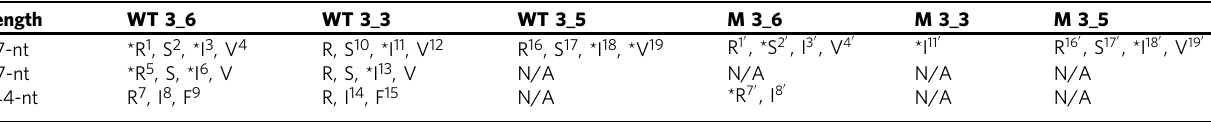
Table 1 FSE systems studied in this work. For each motif (3_6, 3_3, and 3_5) and length (77, 87, and 144-nt) combination, we use fi ve 3D prediction programs (R for RNAComposer, S for SimRNA, I for iFoldRNA, V for Vfold3D, and F for Farfar2) to generate starting